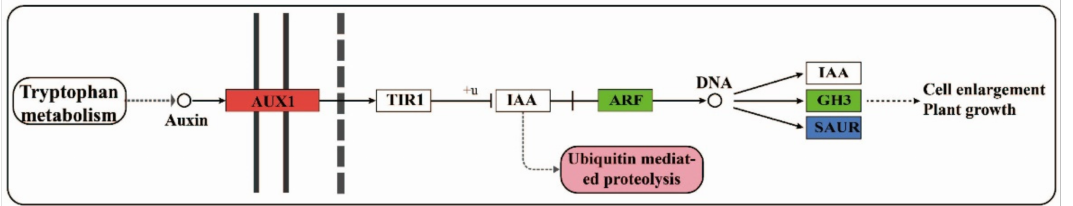
Figure 13. Diagram of auxin signal transduction pathway in F and S cell lines of Korean